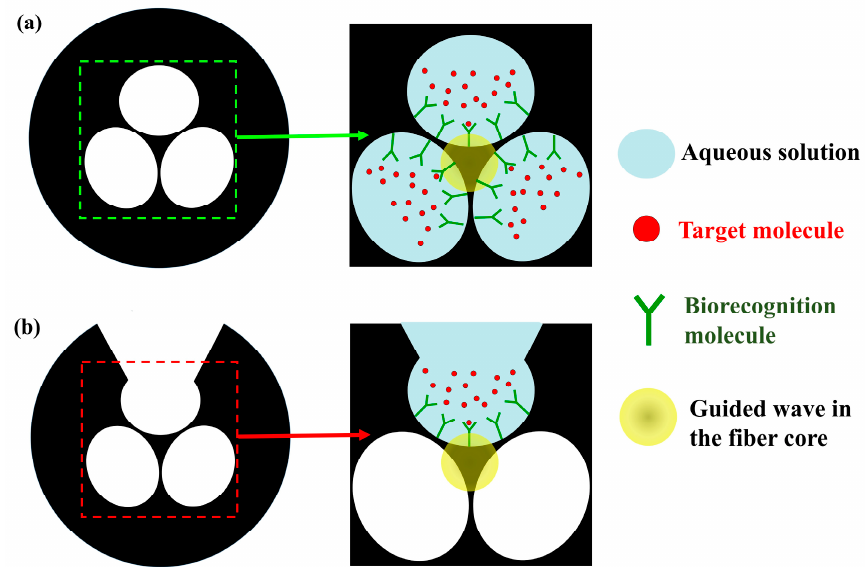
Figure 13. Schematic of surface functionalization for biological and chemical sensing based on ( a ) a conventional SC-MOF, and ( b ) an exposed-core SC-MOF.